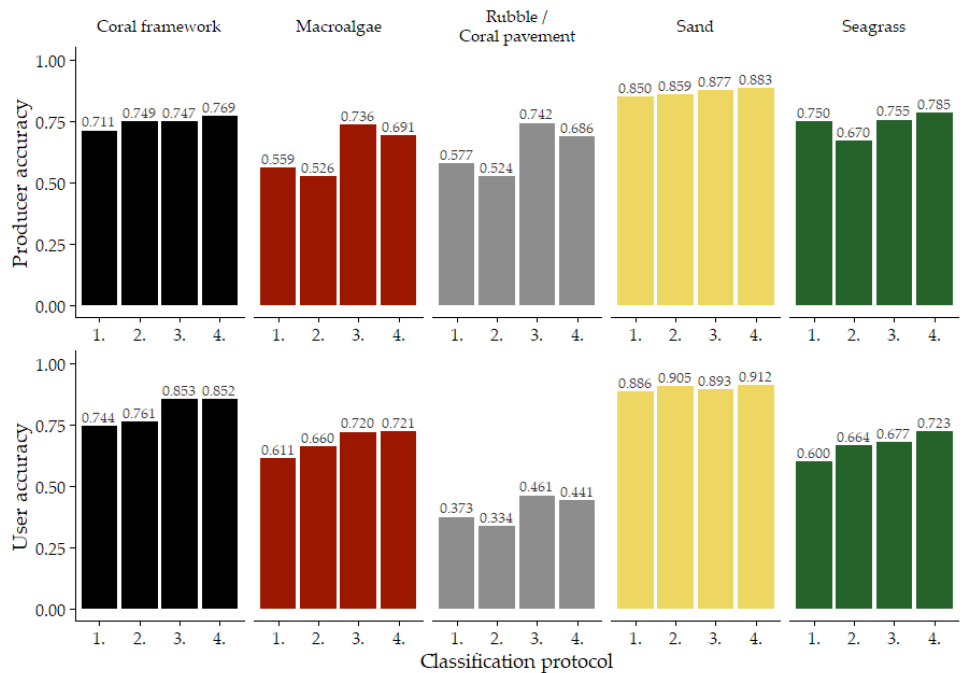
Figure 7. Average producer and user accuracies of the four classification protocols. Classification protocols are indicated by their number (Table 2): 1. ‘Traditional classification’, 2. ‘Using reef zones’; 3. ‘Using geomorphometric features’; 4. ‘Reef zones and geomorphometric features’. For area-specific data, see (Supplementary Material Figures S6 and S7).